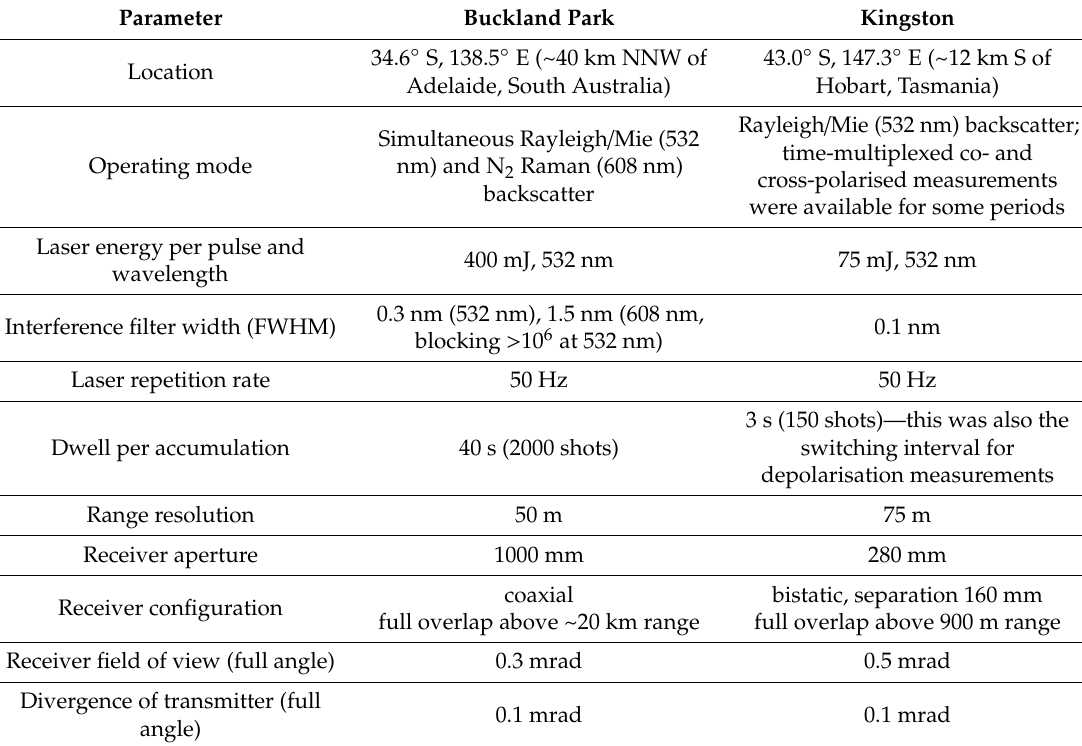
Table 1. Main parameters for the Buckland Park and Kingston